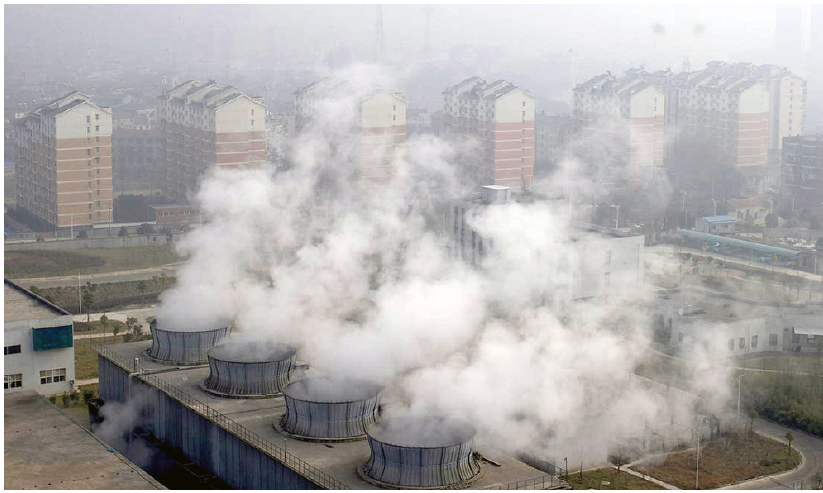
Figure 4. A WTE incineration plant near residential buildings (photos source: [50]).